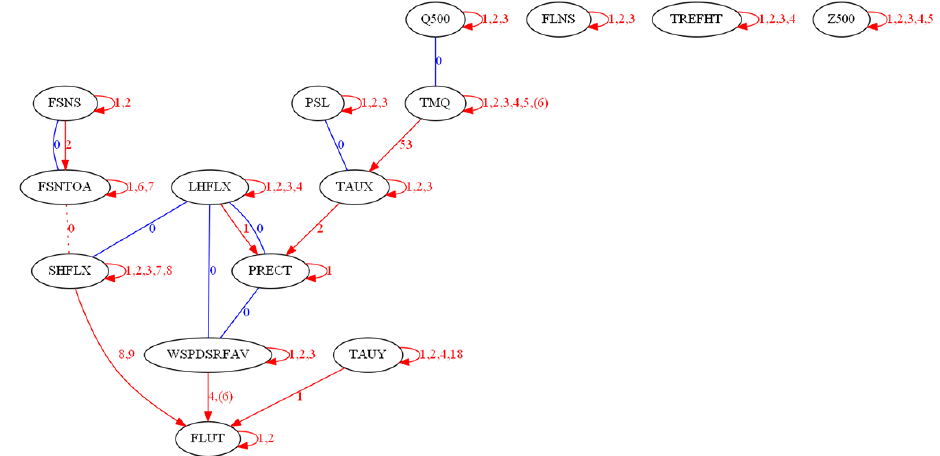
Figure 18. Causal signature interaction map for CESM-LE member 31. Blue lines delineate instantaneous connections and red lines indicate connections with a time lag. The number(s) next to each line give the number of days from potential cause to potential effect. The single dotted line between SHFLX and FSNTOA indicates a very weak instantaneous connection. Note that the causal signature for reconstructed CESM-LE member 31C is identical to this figure, except that the weak connection between SHFLX and FSNTOA is no longer present.